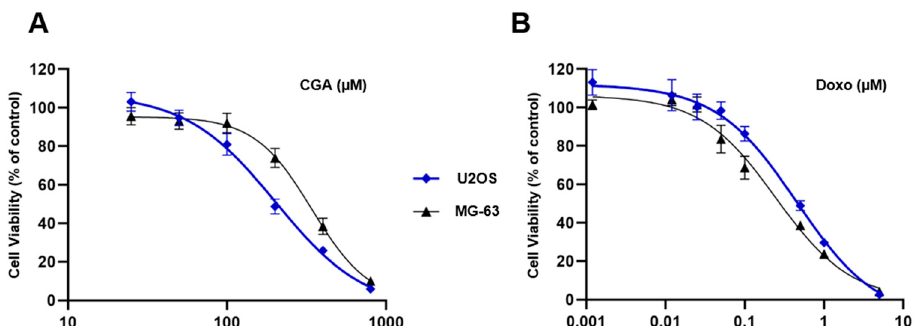
Figure 1. Evaluation of CGA and Doxo-mediated effects in OS cells. U2OS and MG-63 were treated with increasing concentrations of CGA (from 25 to 800 µM) ( A ) and Doxo (from 0.001 to 5 µM) ( B ) for 72 h. Cell viability was estimated by MTT and shown in figure as average rate ± standard deviation (SD) relative to the control of three independent experiments.